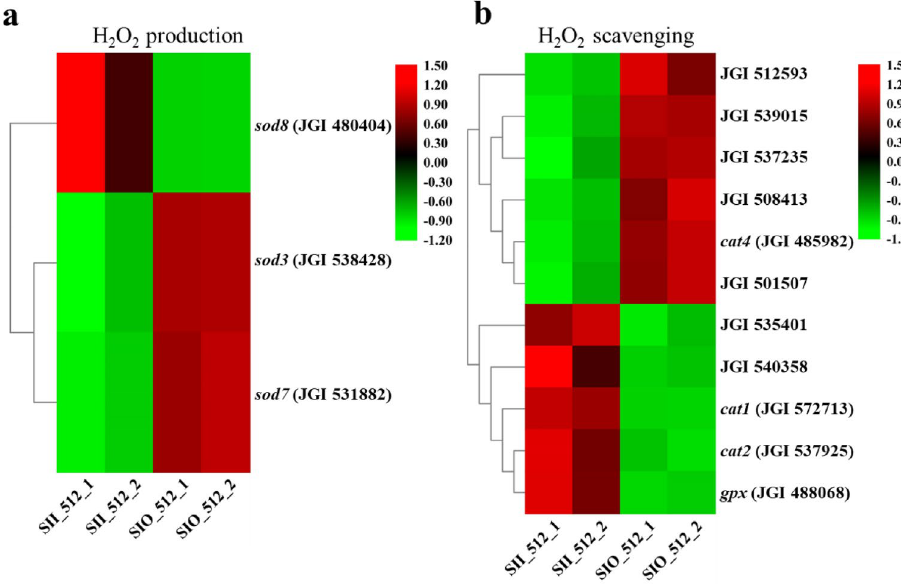
Figure 5. Expression level of DEGs related to H 2 O 2 metabolism. ( a ) Expression of DEGs related to H 2 O 2 - production. ( b ) Expression of DEGs related to H 2 O 2